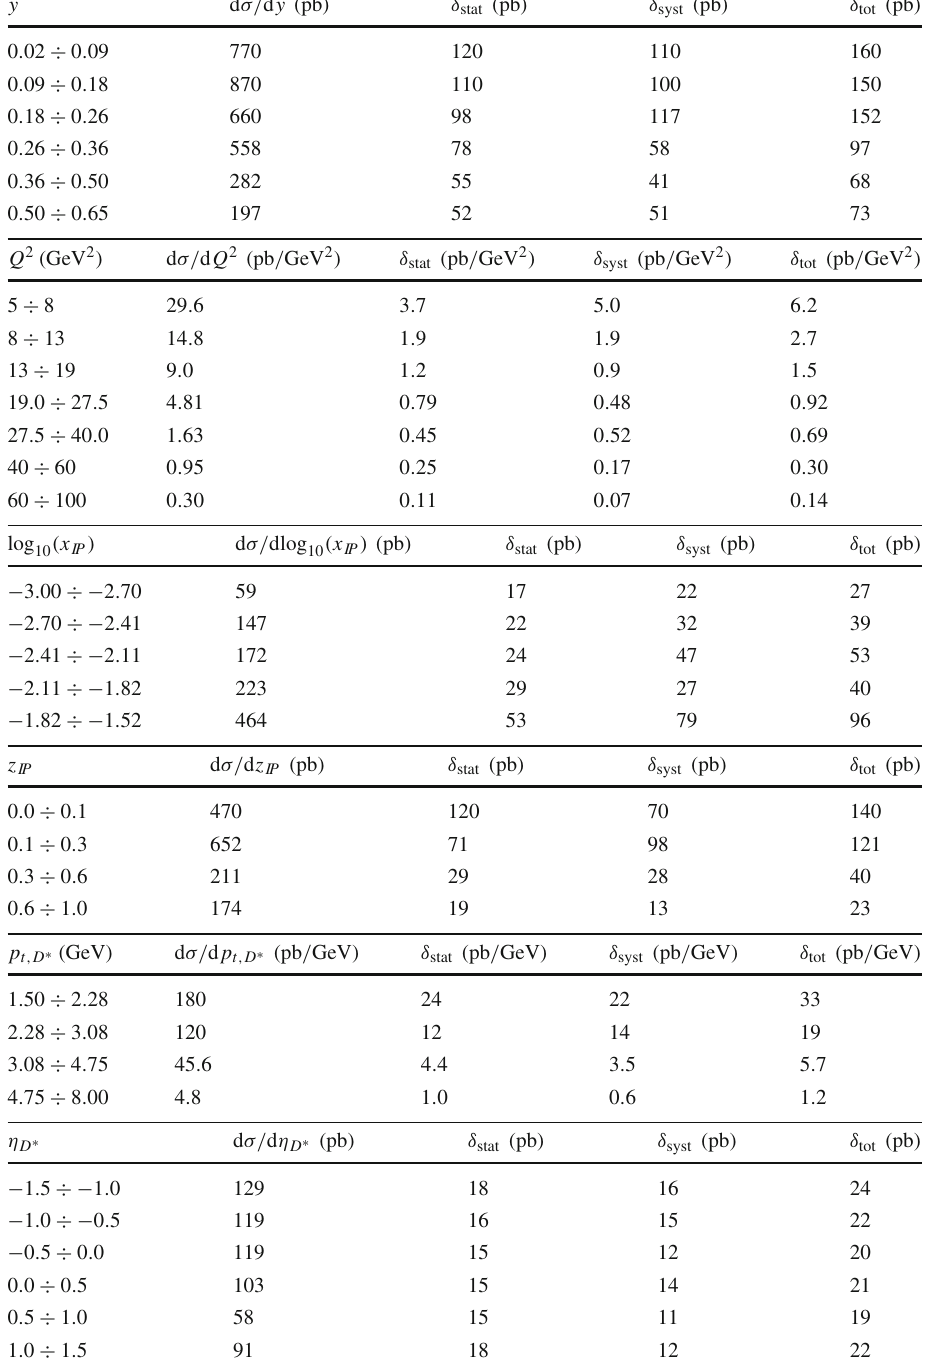
level D ∗ production